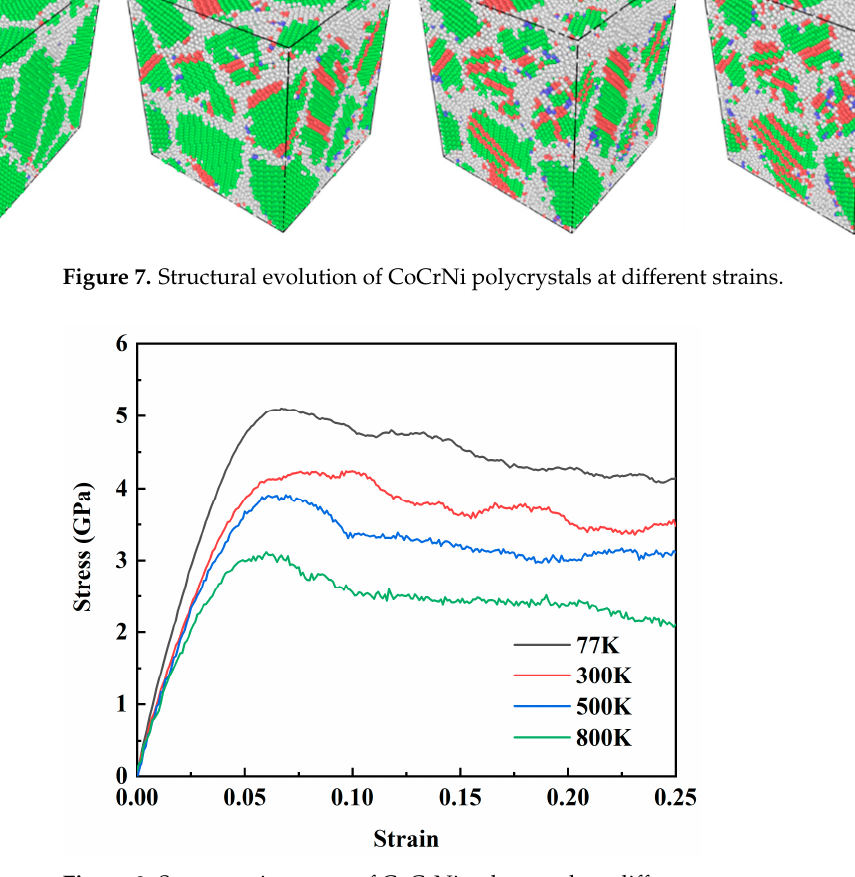
Figure 8. Stress-strain curves of CoCrNi polycrystals at different temperatures.